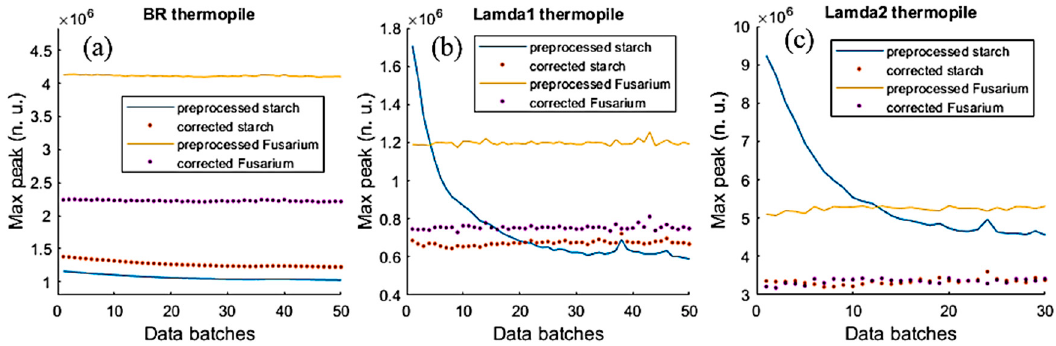
Figure 12. The ACKF preprocessed and corrected data of Fusarium and starch. ( a ) BR thermopile case; ( b ) λ 1 thermopile case and ( c ) λ 2 thermopile case.